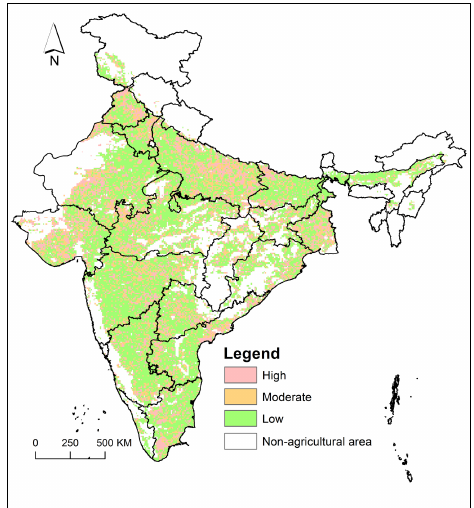
Figure 20 Vulnerability Map of Agricultural Drought During 2003-